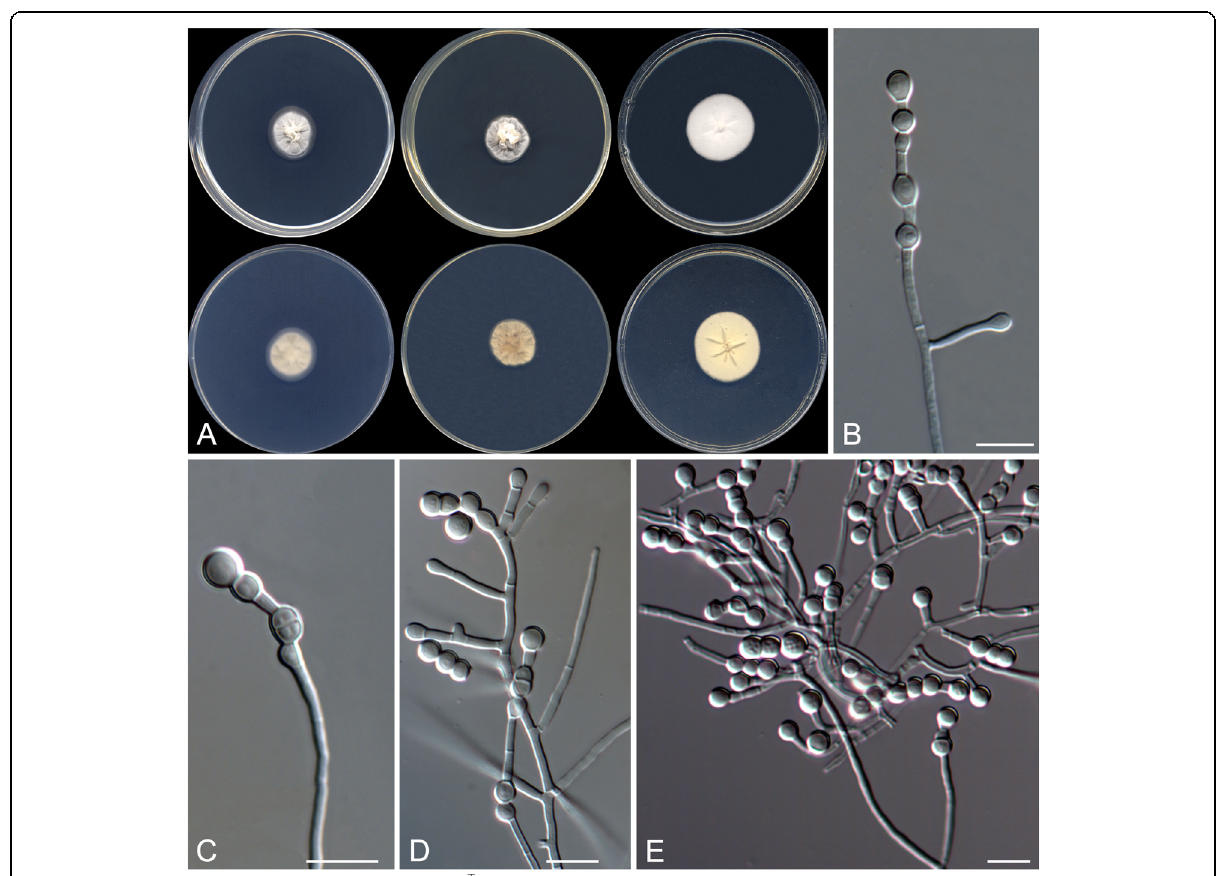
Fig. 6 Strongyloarthrosporum catenulatum CBS 143841 T . a Colonies on G18, G25 N and MY70FG at 25 °C (from left to right), surface and reverse (from top to bottom). b – e Conidiophores and conidia. Scale bar = 10 μ